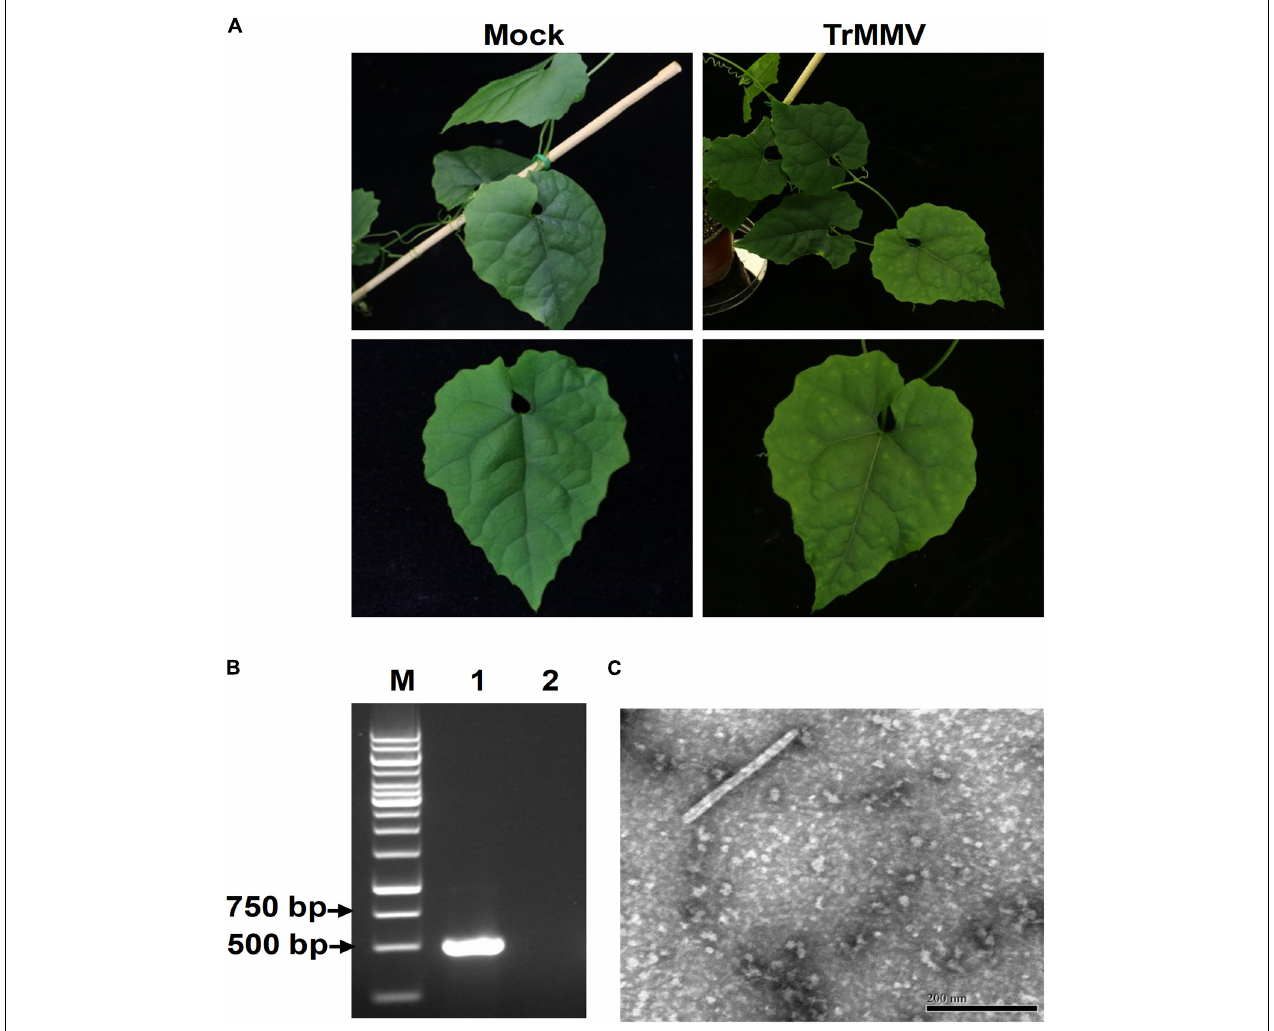
FIGURE 4 | Infectivity of TrMMV on Trichosanthes kirilowii. (A) Leaf mottling and mosaic symptoms of T. kirilowii infected by the TrMMV infectious clone at 17 dpi. (B) RT-PCR analysis of TrMMV RNA accumulation in systemic leaves of inoculated T. kirilowii using TrMMV-specific primers. Lane M, GeneRuler 1-kb DNA ladders (Thermo); lane 1, T. kirilowii plants agroinoculated with pCB301-TrMMV at 17 dpi; lane 2, mock plants inoculated with empty pCB301 vectors. (C) The typical rod-shaped virion in systemic leaves of T. kirilowii plants agroinoculated with pCB301-TrMMV. Bar = 200